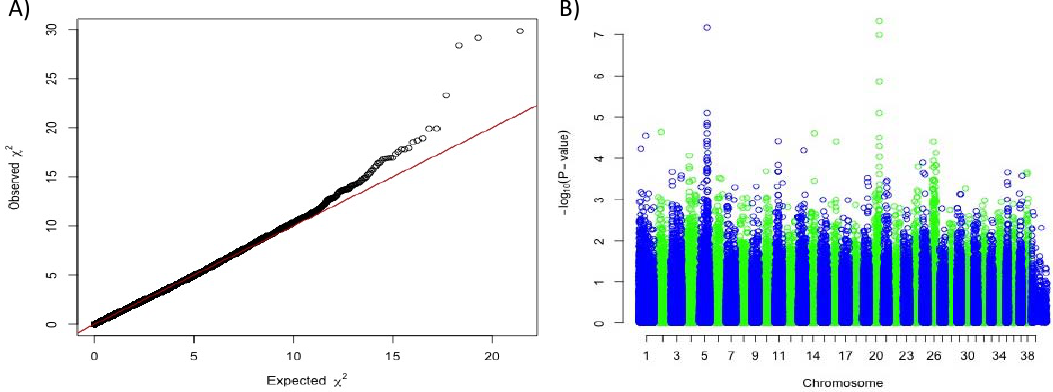
Figure 1. Genome-wide association study results based on 34 white dogs (White Shepherds, Poodles, Cottons de Tulear and Bichons) versus 128 non-white dogs (German Shepherds and Poodles). A) Quantile-Quantile plot displaying a genomic inflation λ of 1.000015, indicating no residual inflation. B) Manhattan plot displaying the results from the GWAS. This analysis pointed out two loci on chromosome 5 (Chr5:63,666,161 p corrected = 6.7 x 10 − 8 ) and on chromosome 20 (Chr20:55,213,866, p corrected = 4.7 x 10 − 8 ).